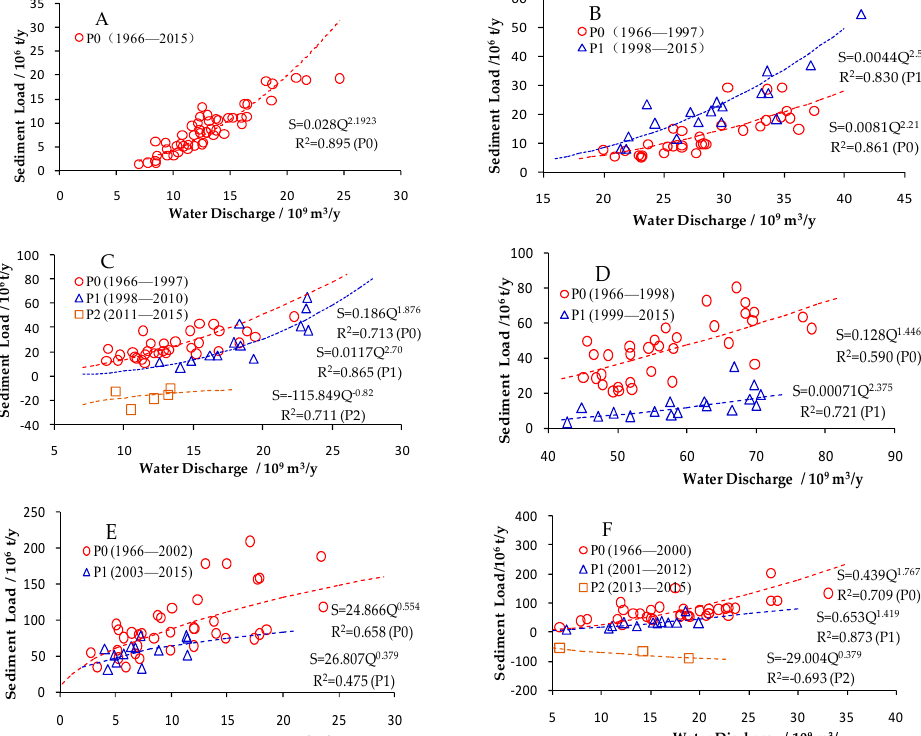
Figure 3. Relationship between water discharge and sediment load in each region of the Jinsha River Basin (P0: the basic period; P1: the first measure phase; P2: the second measure phase); A : Upstream region of the Zhimenda Station; B : Region between the Zhimenda and Shigu Station; C : Region between the Shigu and Panzhihua Station; D : Yalong River Basin; E : Region between the Panzhihua and Huatan Station (excluding the Yalong River basin); F : Region between the Huatan and Pingshan Station ).